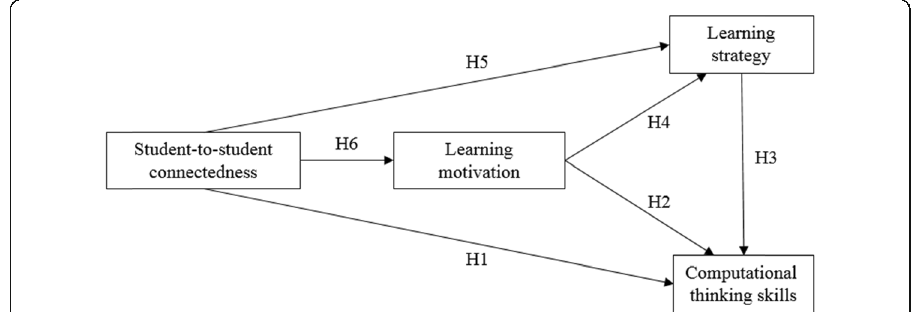
Fig. 1 Proposed research model and